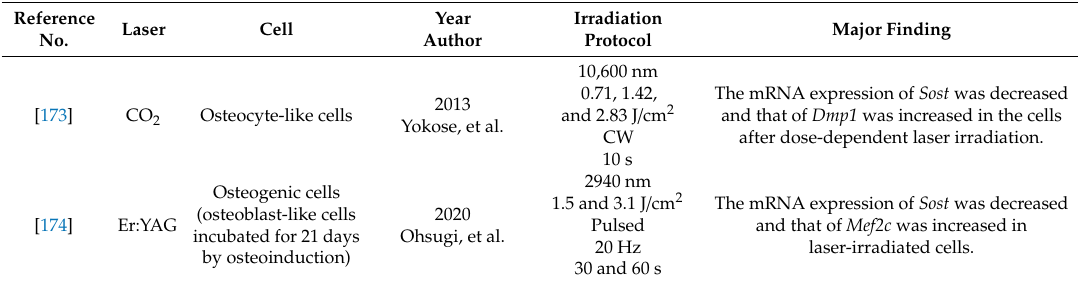
Table 7. Summary of the e ff ects of laser irradiation on osteocytes.